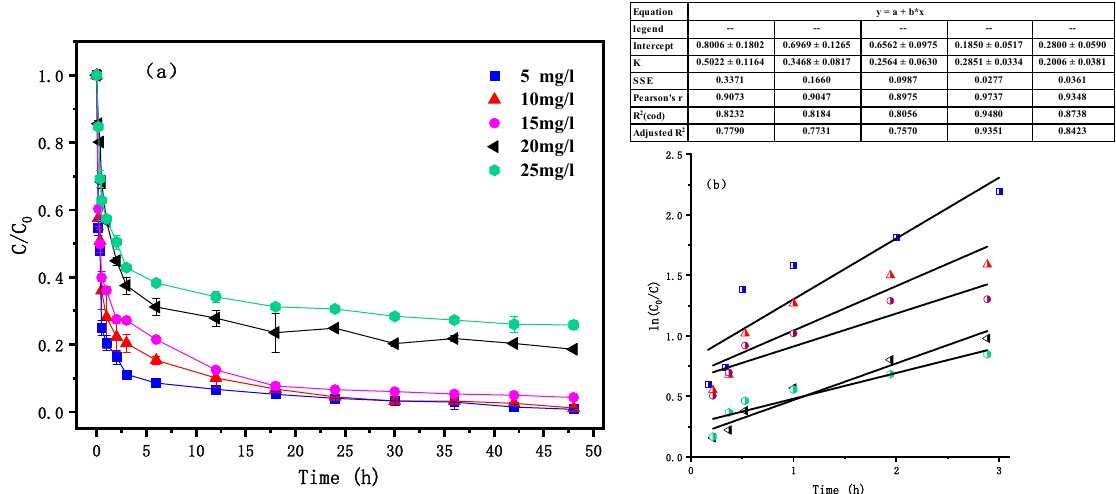
Figure 11. Effect of initial PNP concentration and linear fitting. PNP degradation curves with dif- ferent initial concentrations ( a ), Dynamic fitting curve ( b ).